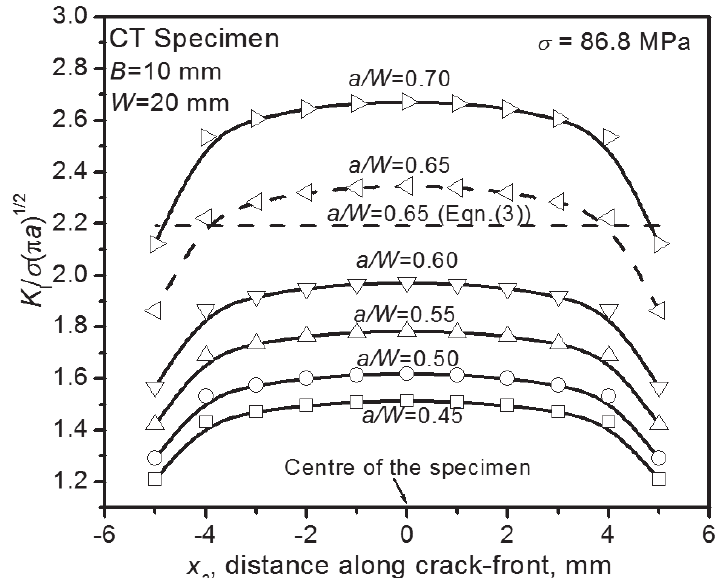
Figure 3: Effect of a/W on normalized stress intensity factor, K I /  (  a) 1/ 2 along crack-front (x 3 ) for B =10mm.